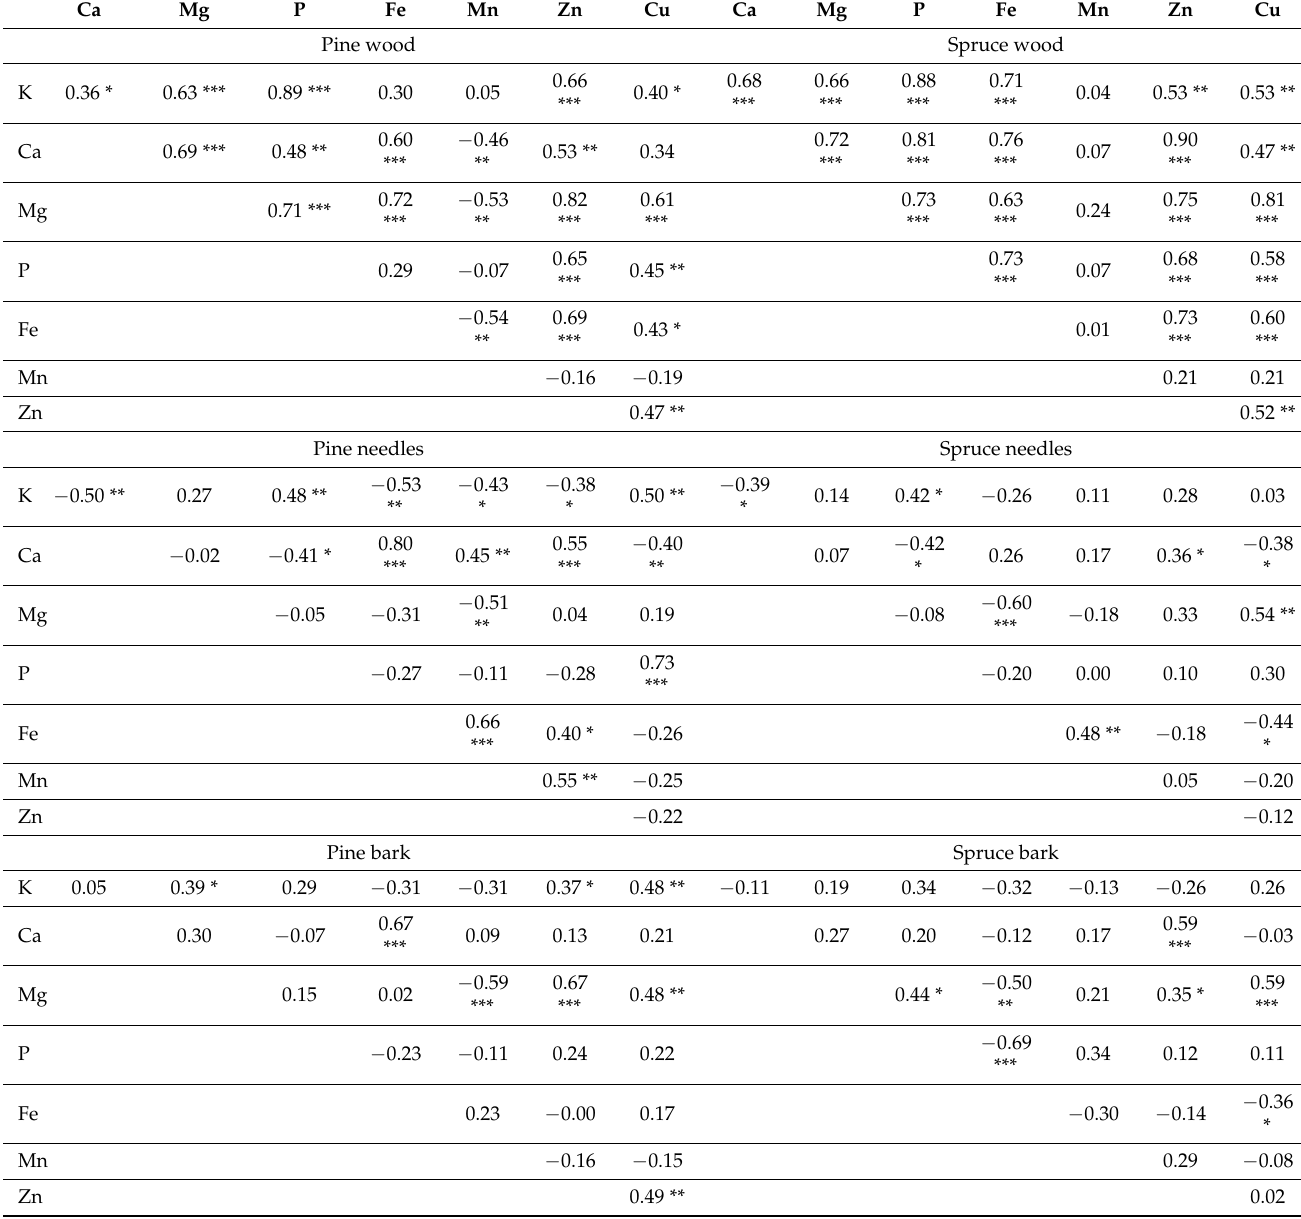
Table 1. Pearson’s correlation coefficients ( r ) between element contents in plant